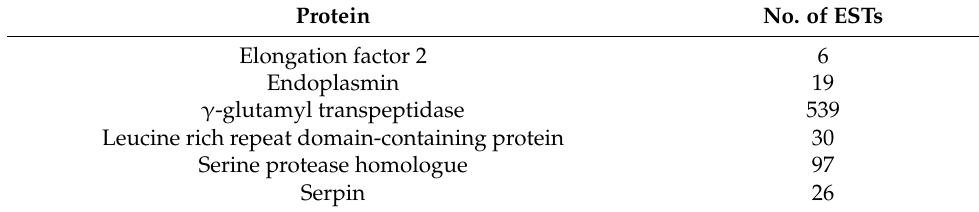
Table 3. Putative venom protein components of Aphidius ervi . (Source: data from [48]). Protein No. of ESTs Elongation factor 2 6 Endoplasmin 19 γ -glutamyl transpeptidase 539 Leucine rich repeat domain-containing protein 30 Serine protease homologue 97 Serpin